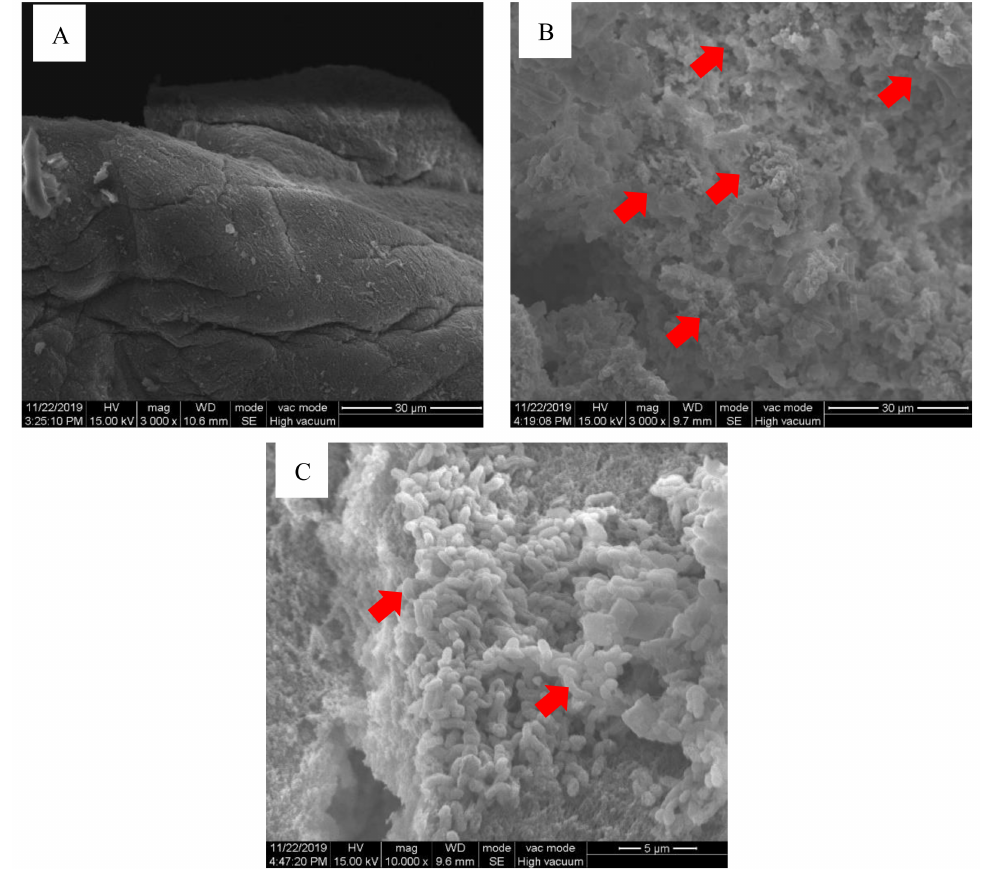
Figure 2. Scanning electron microscopy (SEM) micrograph showing a Photobacterium damselae subsp. damselae biofilm growth on a chitosan particle. ( A ) Chitosan particle surface without Photobacterium damselae subsp. damselae . ( B ) Biofilm growth on a chitosan particle at 48 h (arrows: Photobacterium damselae subsp. damselae biofilm). Magnification: 3000 × ; bars = 30 µ m. ( C ) Biofilm growth on a chitosan particle at 48 h (arrows: Photobacterium damselae subsp. damselae biofilm). Magnification: 10,000 × ; bars = 5 µ m.